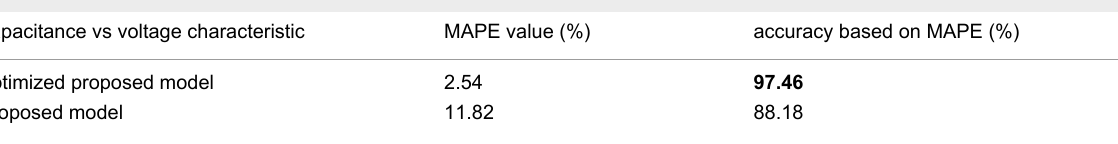
the proposed single-layer graphene quantum capacitance model, the optimized proposed model and the experimental extracted data, as graphs.